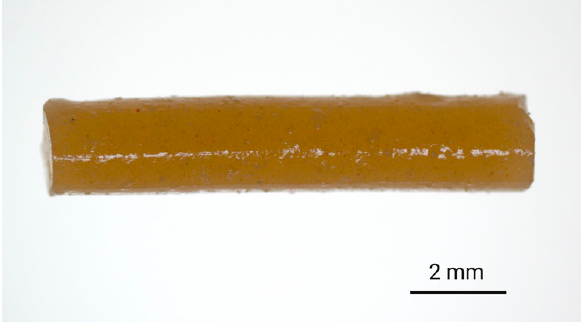
Figure 2. Digital image of the 8:2-PLGA-3% implant (ALN 3% w / w ) containing tartrazine dye (0.2% w / w ), incorporated to provide a visual indication of the distribution of additives (i.e., dye and drug) within the polymer matrix.